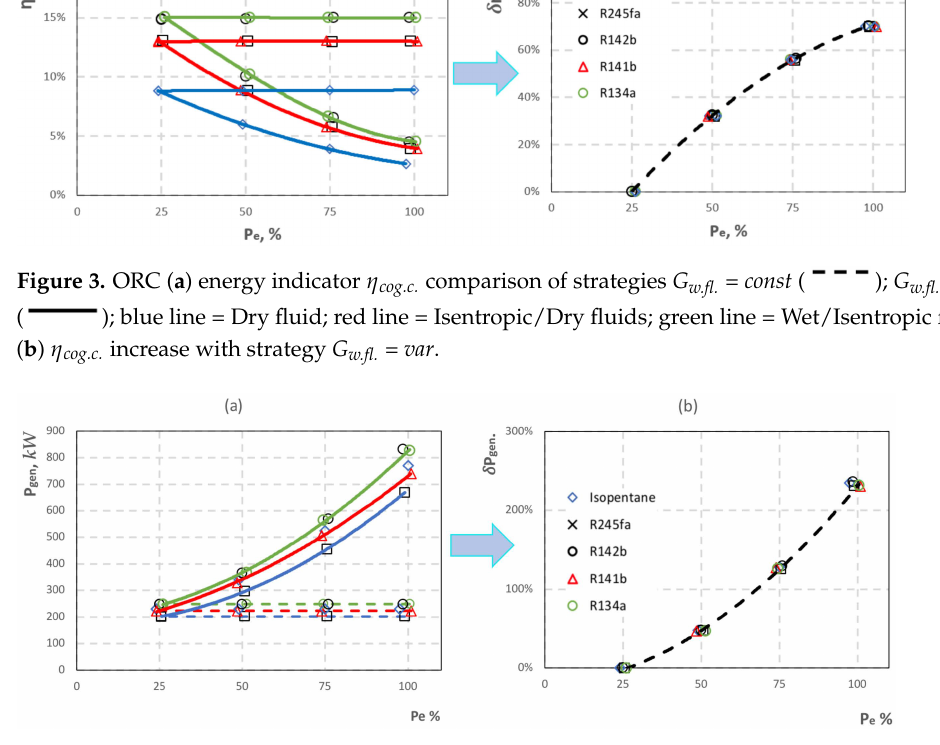
Figure 4. ORC ( a ) energy indicator P gen comparison of strategies G w.fl. = const ( ); blue line = Dry fluid; red line = Isentropic/Dry fluids; green line = Wet/Isentropic fluids; ( b ) P gen increase with cogeneration cycle with strategy G w.fl. = var .